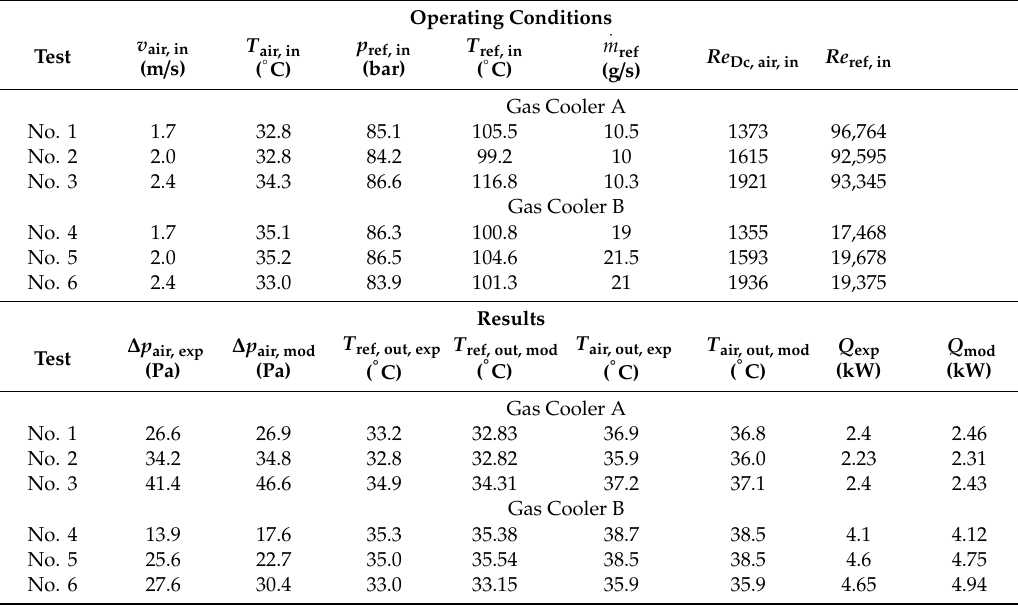
Table 1. Comparison of modelling results with experimental data